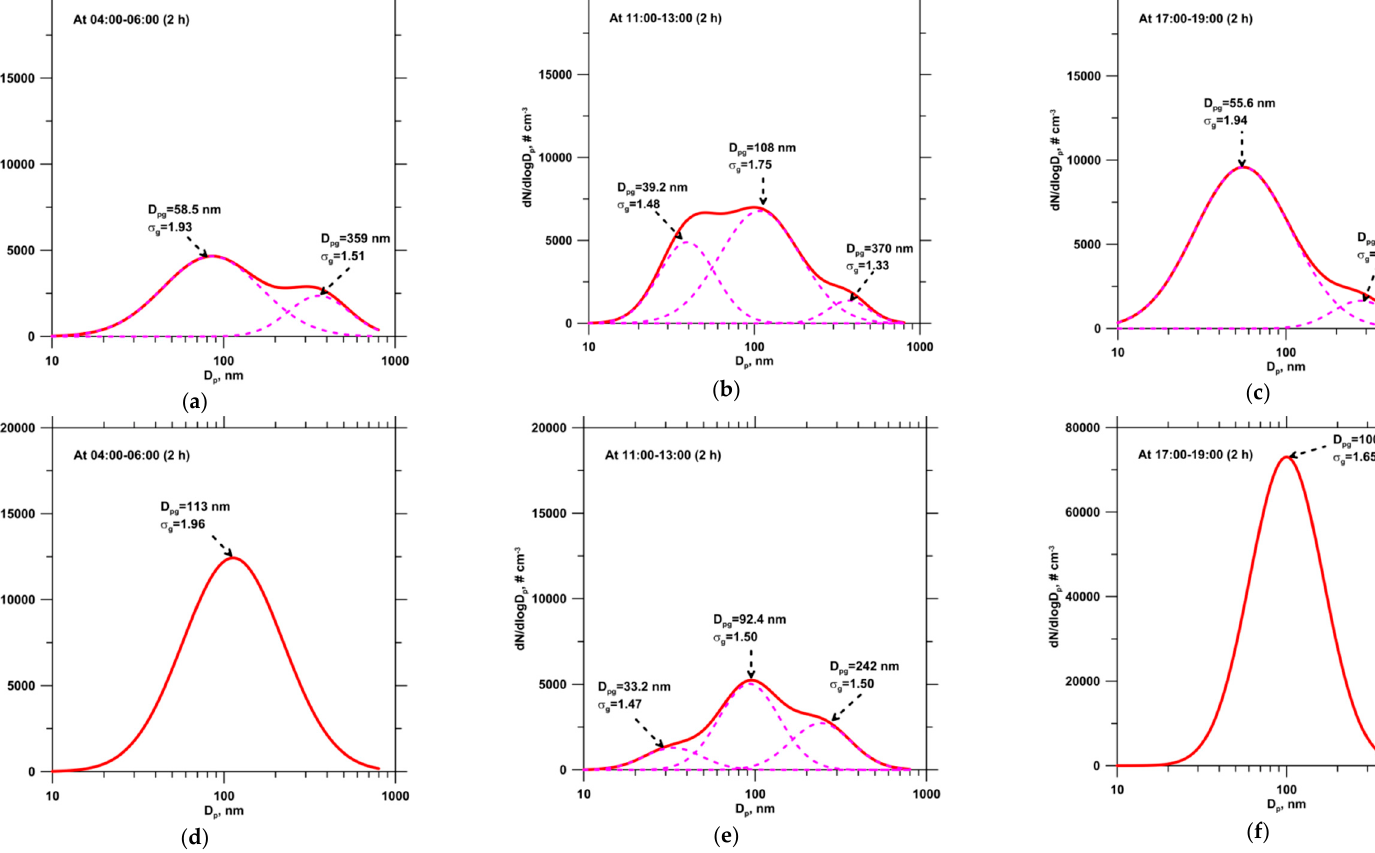
Figure 8. Average particle number size distributions measured on reference day during ( a ) predawn hours; ( b ) midday hours; and ( c ) evening hours; and on event day during ( d ) predawn hours; ( e ) midday hours; and ( f ) evening hours.